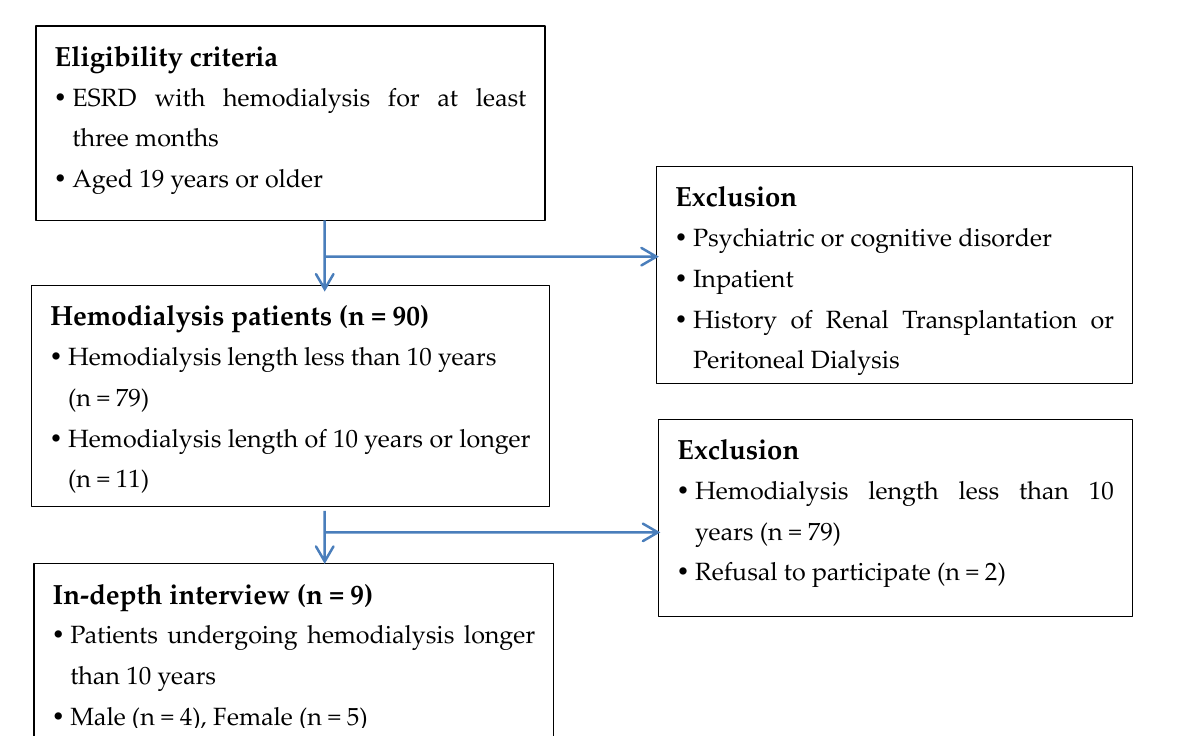
Figure 1. Inclusion and exclusion criteria of participants. Table 1. Participant demographics and information.